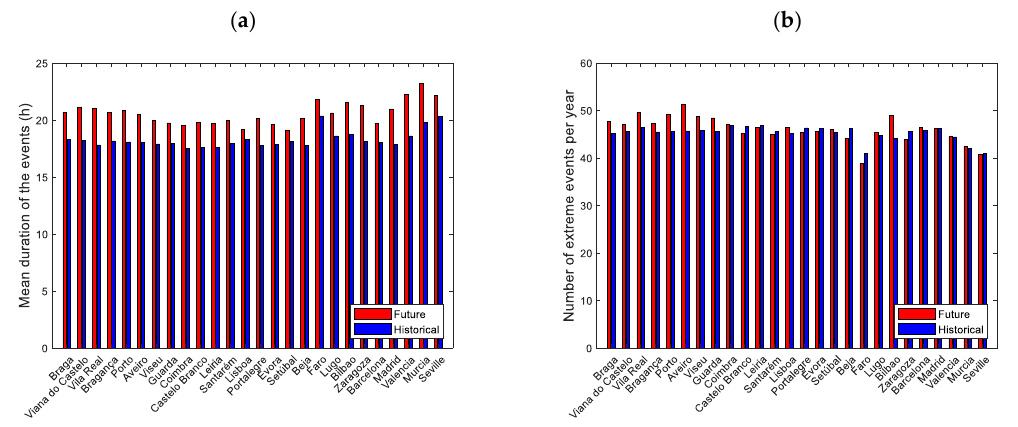
Figure 16. ( a ) Mean duration (hours) of extreme events of the wind speed at 300 hPa and ( b ) the number of extreme events per year, for historical (blue) and future (red) climates and for all cities.